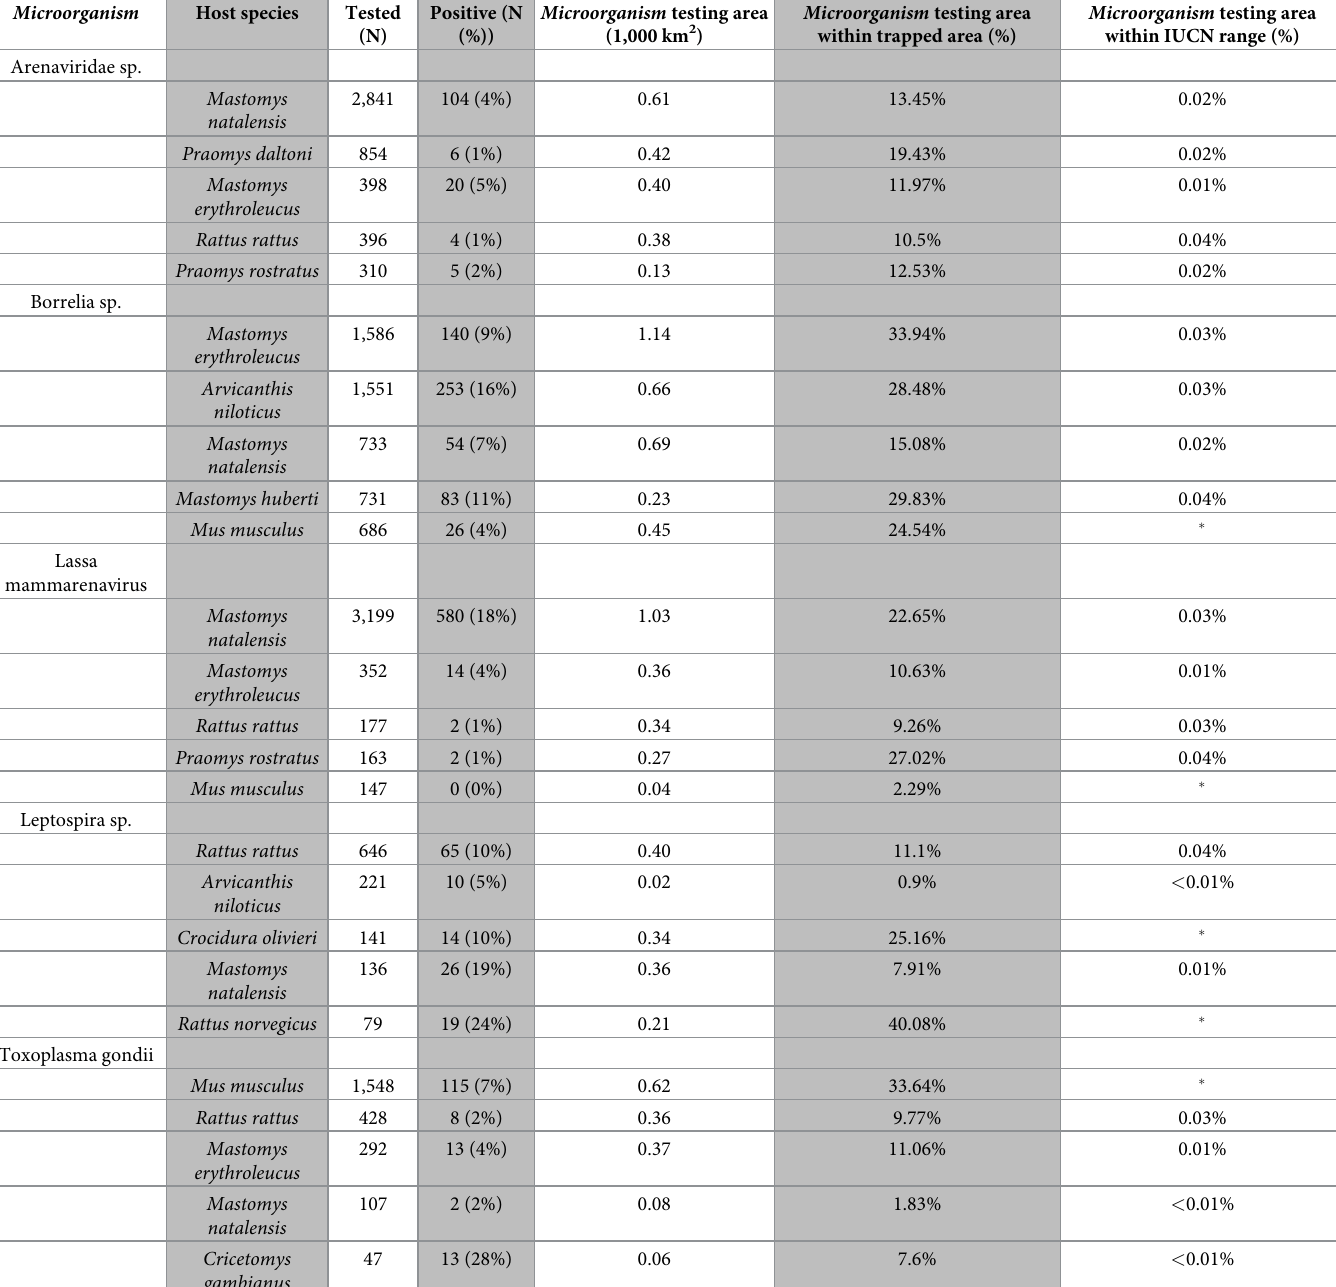
Positive (N Microorganism testing area Microorganism testing area (N) (%)) (1,000 km 2 ) within trapped area (%)